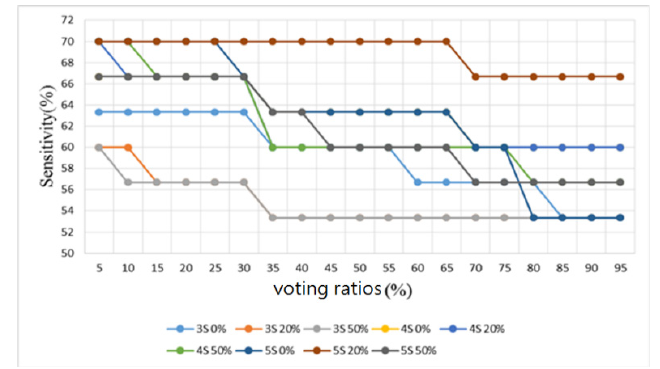
Figure 20. Lung sound classification results: Accuracy.